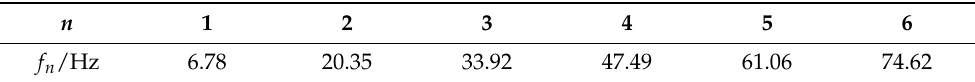
Table 1. The propagation frequencies of first 6-order normal